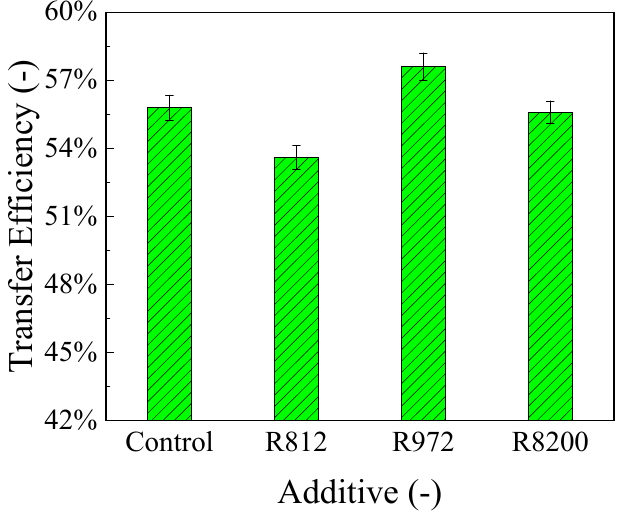
Figure 7. Transfer efficiency of powder samples.